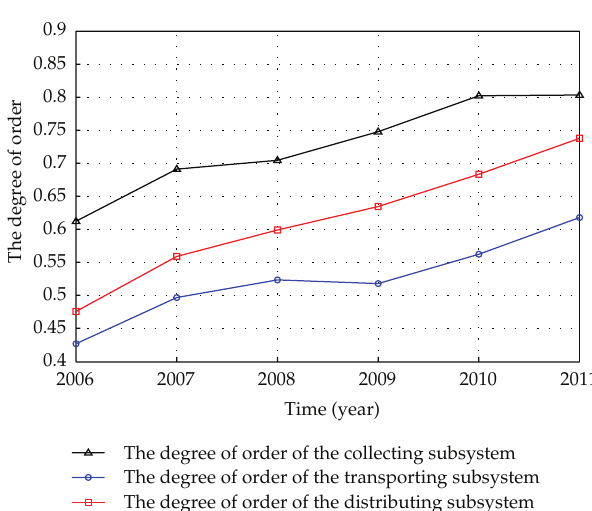
Figure 1: The change of degree of order of each